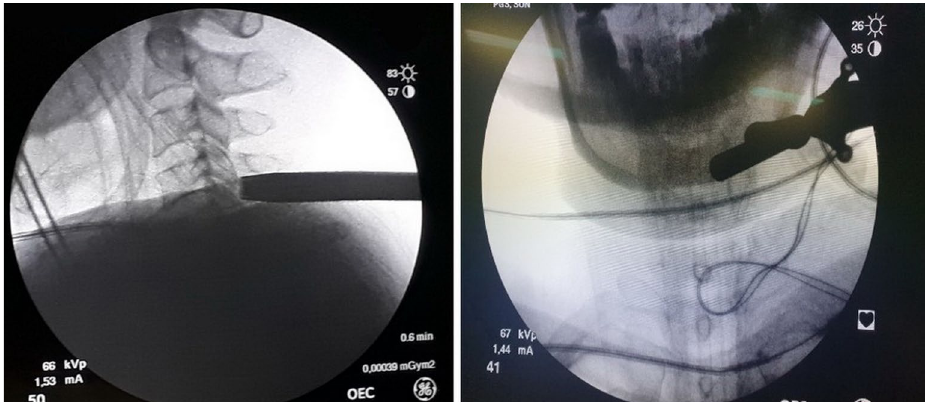
Figure 3. Working channel Insertion. On a string conductor, tubular reamers of increasing diameter were introduced, on which a working cannula with a beveled cut with an external diameter of 7.5 mm was installed.